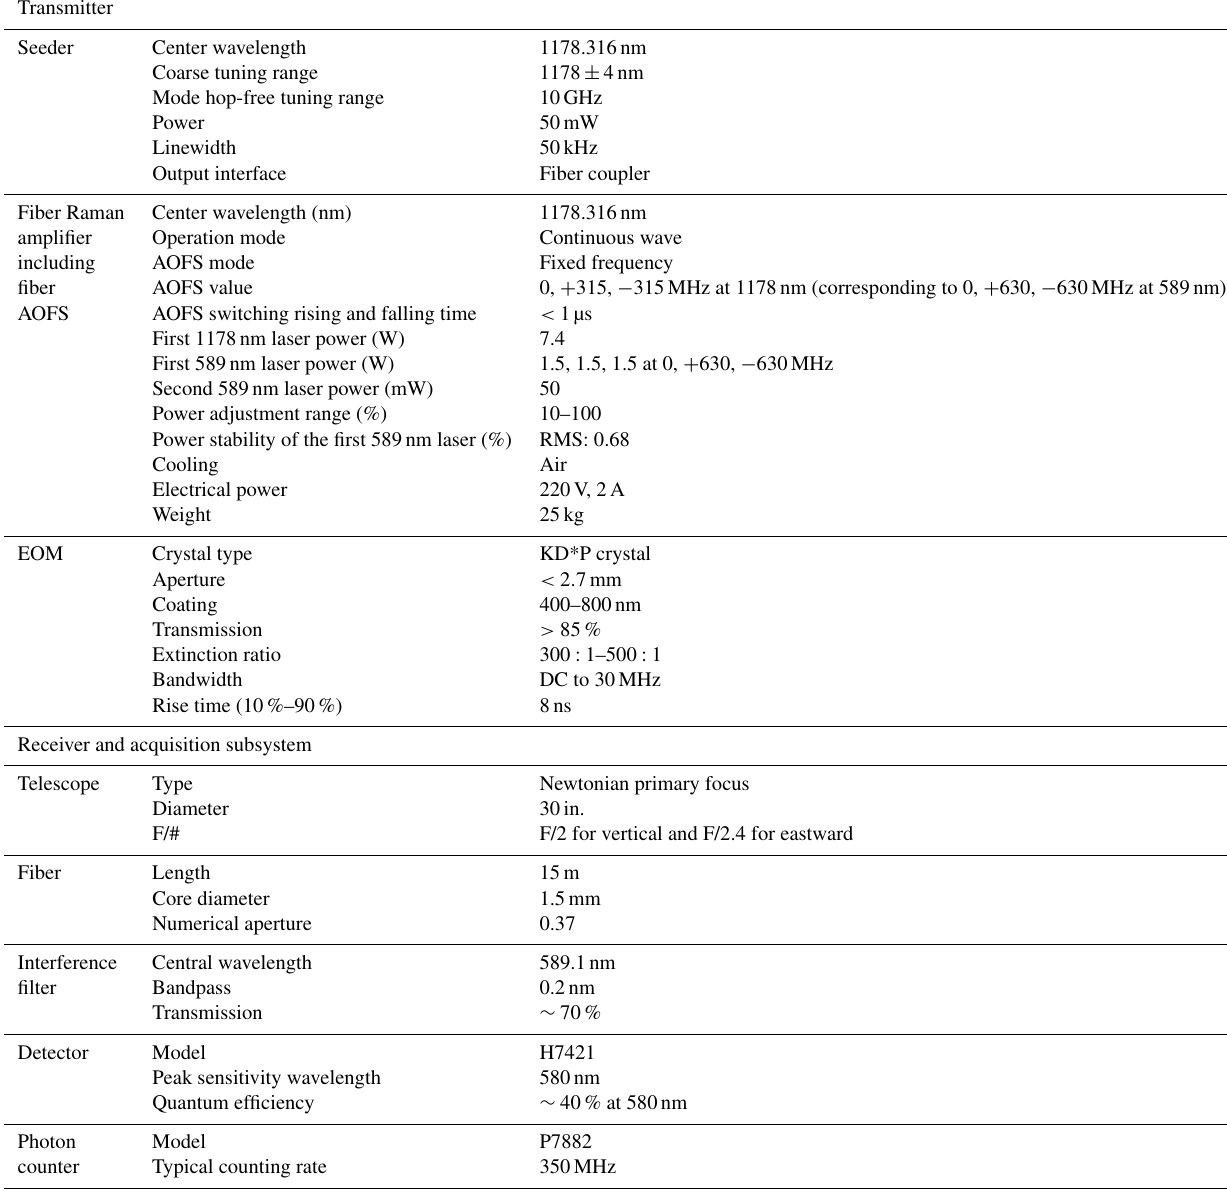
Table 2. Technical specifications of the